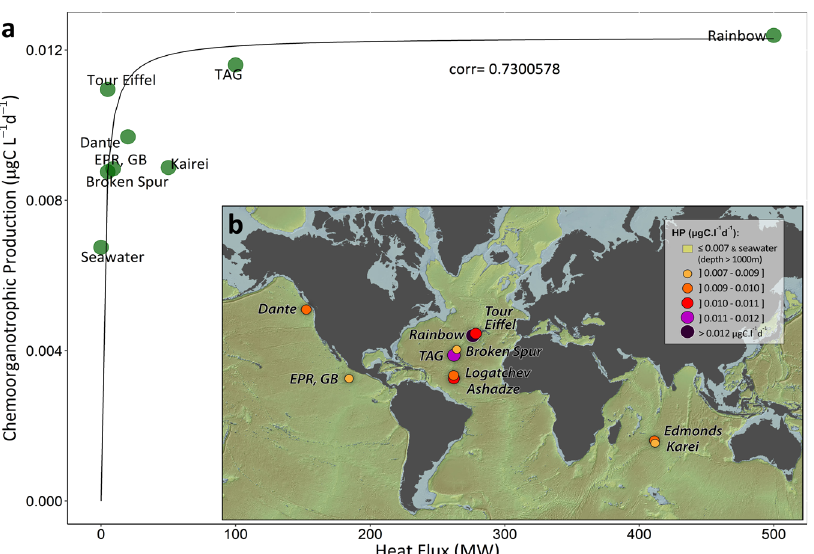
Fig. 2 Global prokaryotic biomass production through chemoorganotrophic processes within non-buoyant hydrothermal plumes. a Chemoorganotrophic production rates as a function of heat fl ux for various hydrothermal sites from the Mid-Atlantic Ridge (MAR: Rainbow, Tour Eiffel, Broken Spur, TAG), the East-Paci fi c Rise - Grand Bonum site (EPR, GB), the Main Endeavor vent fi eld (Dante), and the Central Indian Ridge (CIR: Kairei). b Global map of the chemoorganotrophic production rates within the non-buoyant plume for the following hydrothermal sites on the MAR (Rainbow, Tour Eiffel, Logatchev, Broken Spur, TAG, Ashadze), the EPR (Grand Bonum, EPR, GB), the Main Endeavor vent Field (Dante), and the CIR (Kairei,